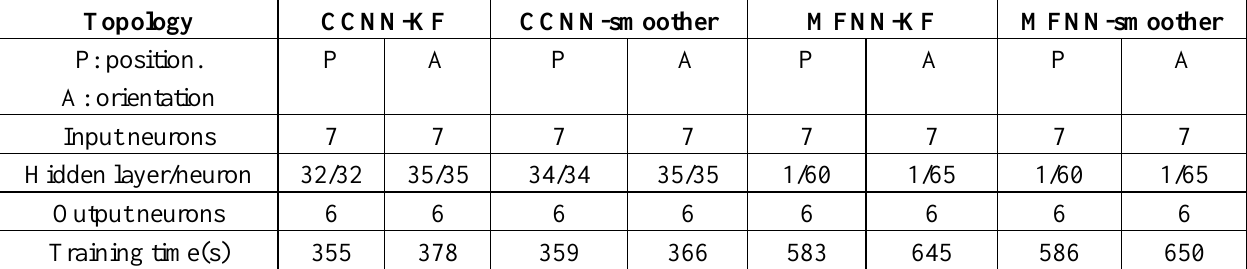
Table 1 . The topology comparison of CCNN and MFNN based schemes.